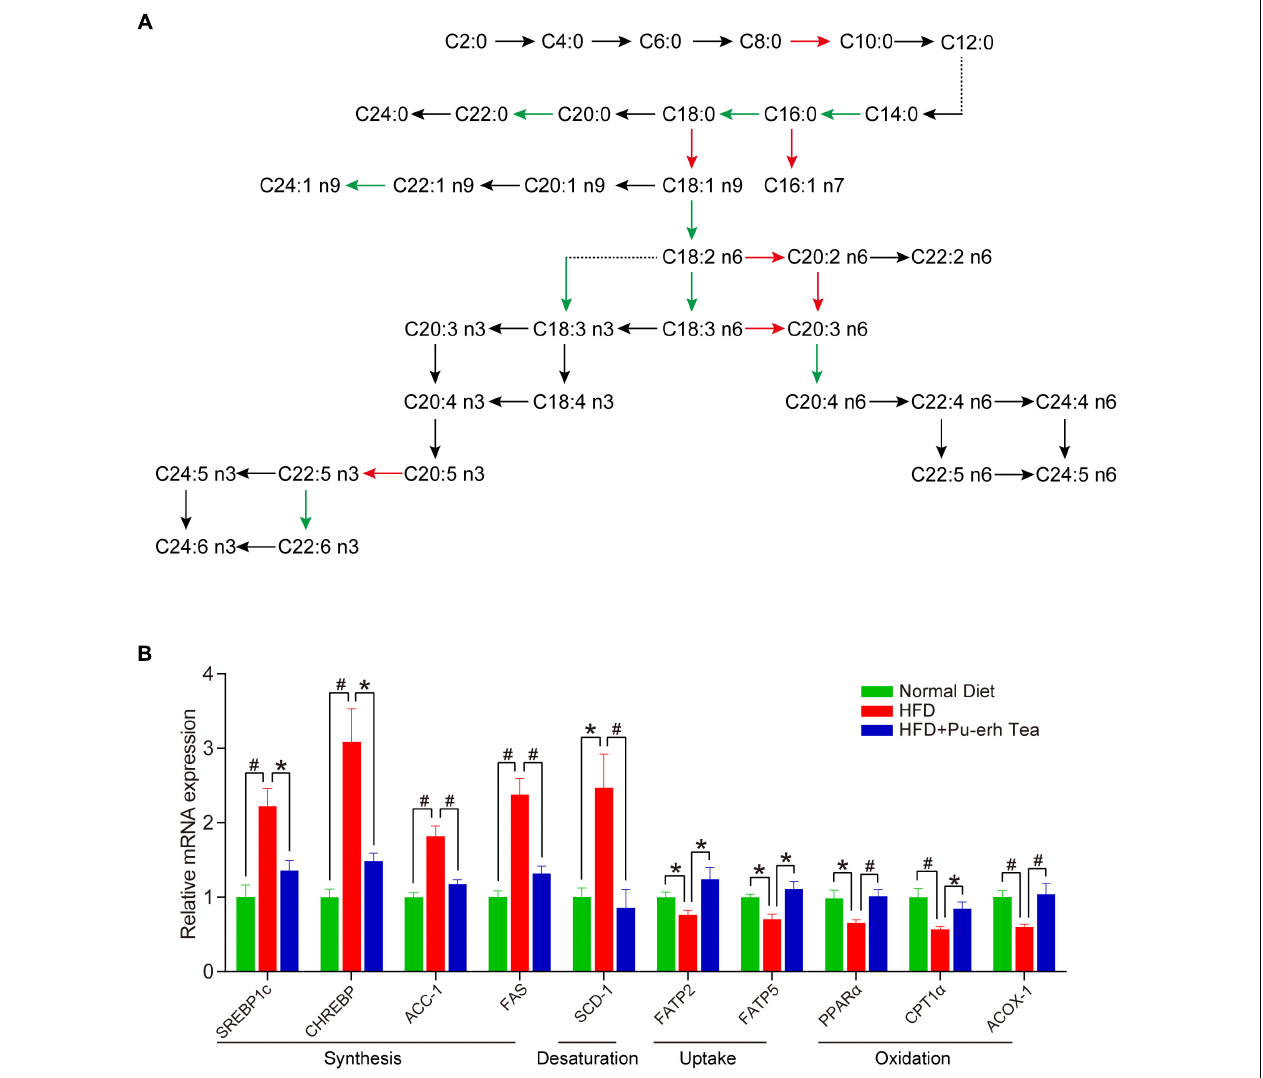
FIGURE 5 | Pu-erh tea altered FA related enzymatic activities and gene expression. (A) Biochemical synthesis pathway related to FA metabolism and ratios regulated by HFD and Pu-erh tea. Red arrows represent the ratios significantly elevated by HFD but attenuated by Pu-erh tea, while the green arrows represent the ratios significantly lowered by HFD but elevated by Pu-erh tea. (B) Hepatic gene expression related to FA metabolism of mice fed with control diet, HFD, and HFD with 450 mg/Kg/day Pu-erh tea for 22 weeks. Data were expressed as mean ± SEM and differences were assessed by Mann–Whitney U test, ∗ p < 0.05, # p <